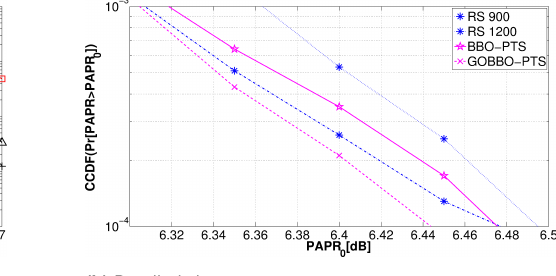
(a) Total (b) Detailed